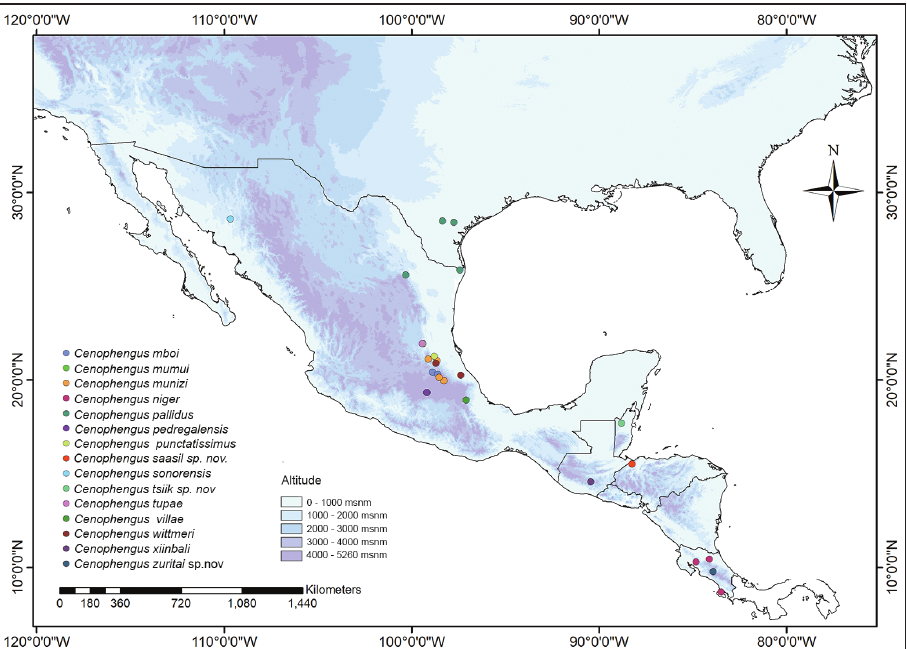
Figure 19. Map of southern North America showing specimen localities for Cenophengus spp.